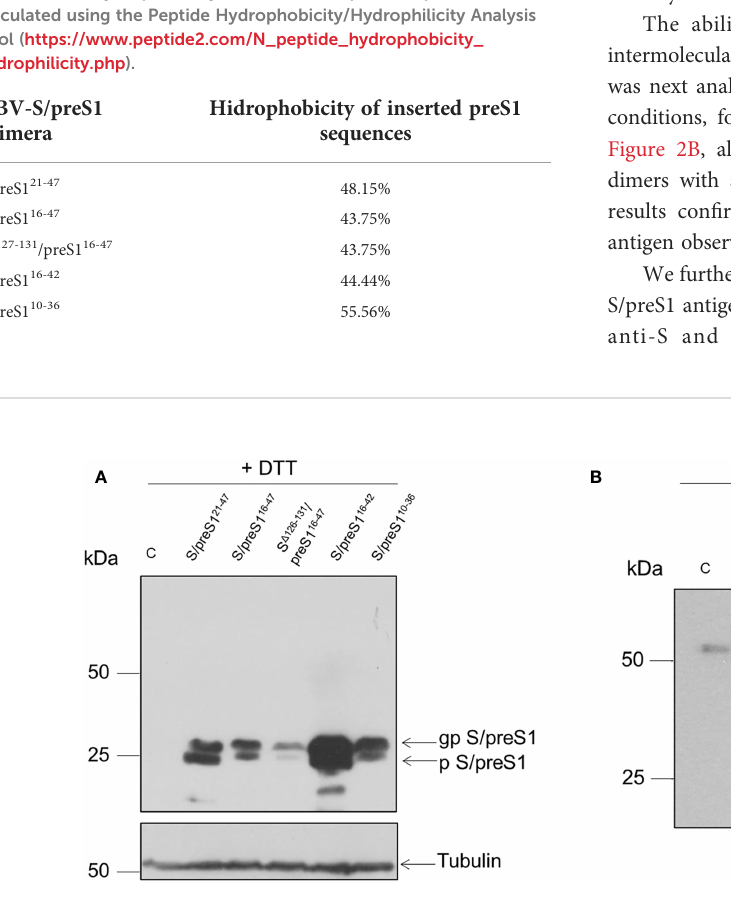
TABLE 2 The hydrophobicity of the inserted preS1 sequences was calculated using the Peptide Hydrophobicity/Hydrophilicity Analysis